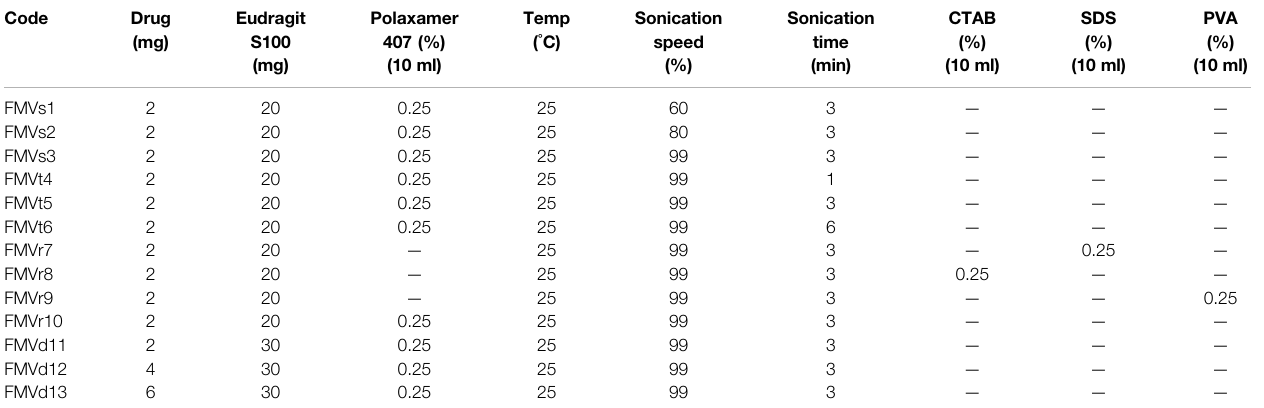
TABLE 2 | Effect of process variables on particle size and encapsulation ef fi ciency of methotrexate nanoparticles with Eudragit S100.